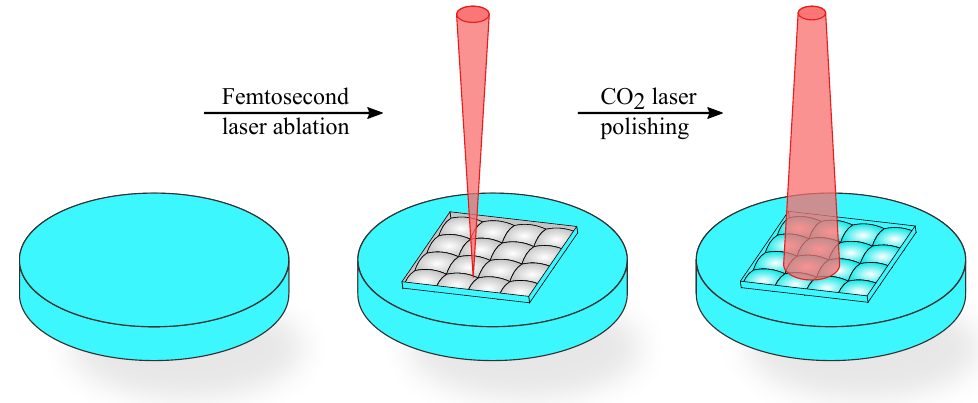
Figure 2. Schematic of the all laser-based lens array fabrication process. First, the predefined geometry is generated out of the bulk silica sample in a layer-by-layer ablation process by femtosecond pulsed laser. Second, a CO 2 laser is applied to reduce the previously introduced surface roughness finalizing the optical